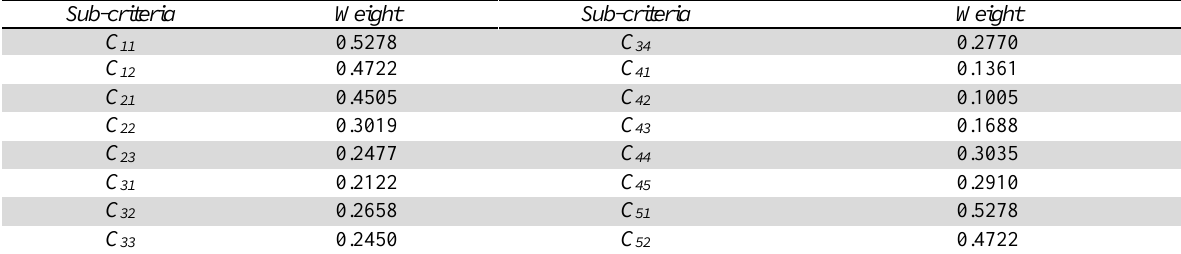
Weights of sub-criteria